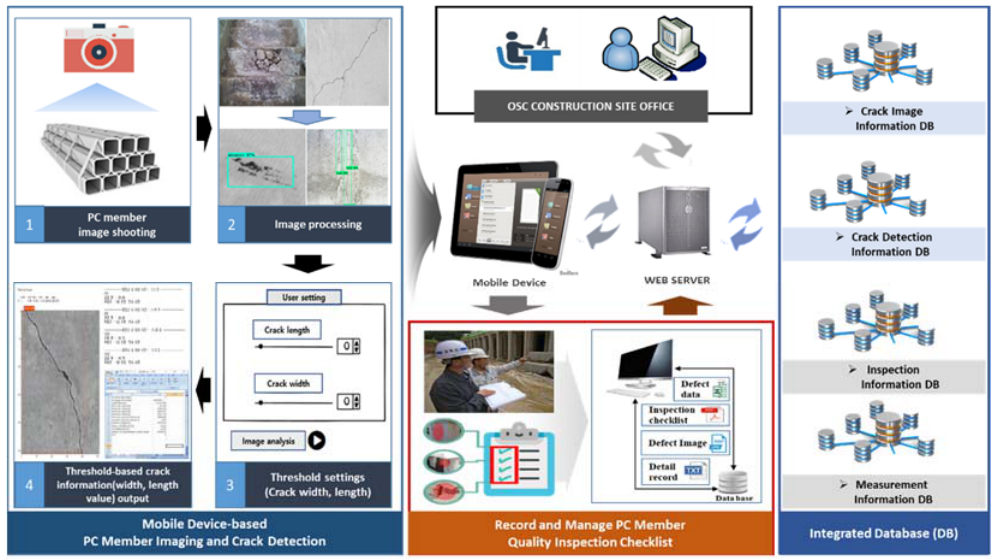
Figure 12. Conceptual diagram of the automated PC member crack detection system.